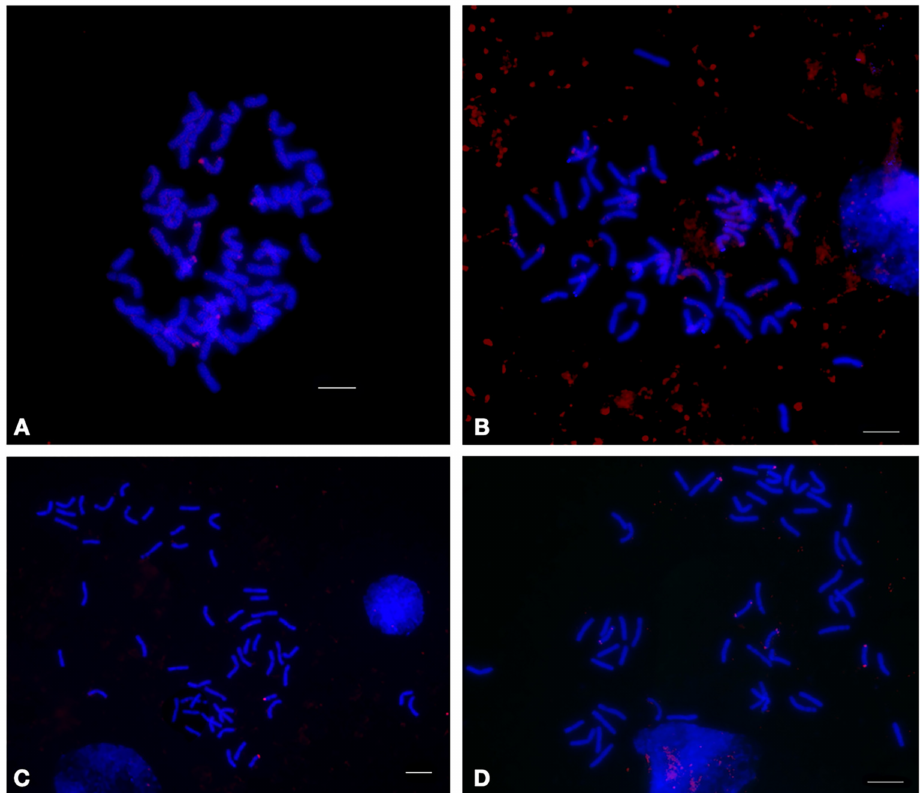
Figure 7. Localization of the 17-62 tandem repeat on the metaphase chromosomes of the wheat- wheatgrass hybrids ( A ) ZP26; ( B ) 166; ( C ) 4044; and ( D ) 548, using fluorescence in situ hybridization. Red signals indicate the chromosomal localization of the 17-202 tandem repeat. The bar indicates 10 µ